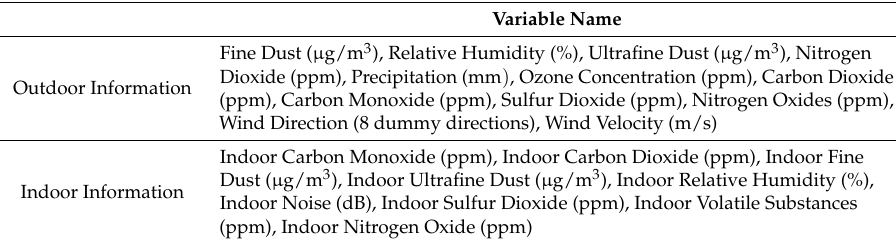
Table 3. List of variables.